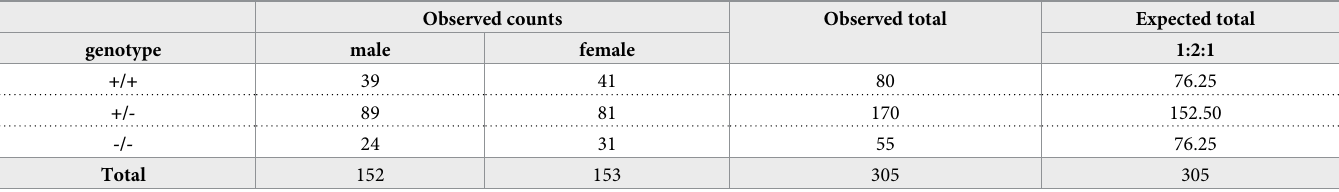
Table 4. Many Poldip2 knockout mice are viable.